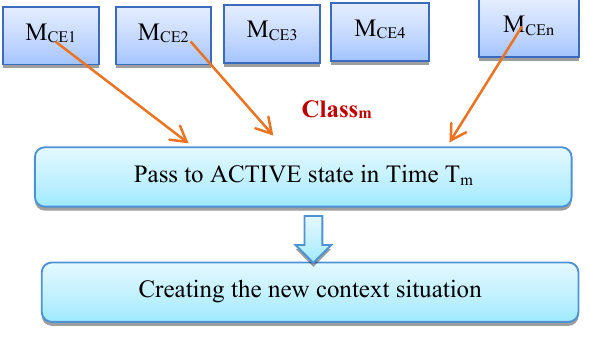
Figure 5 . Processes of our